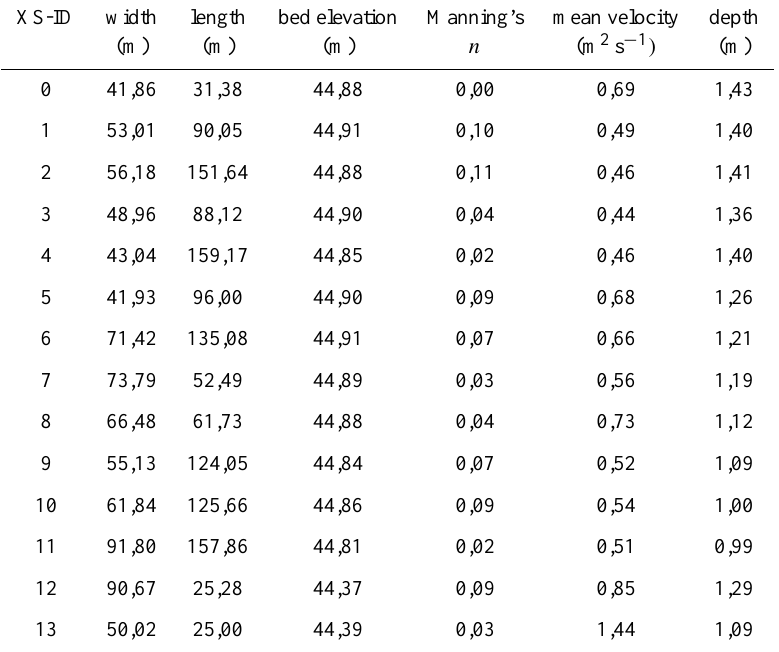
Table 3. Model geometry and boundary conditions estimated for an initial discharge of 25m 3 s − 1 .